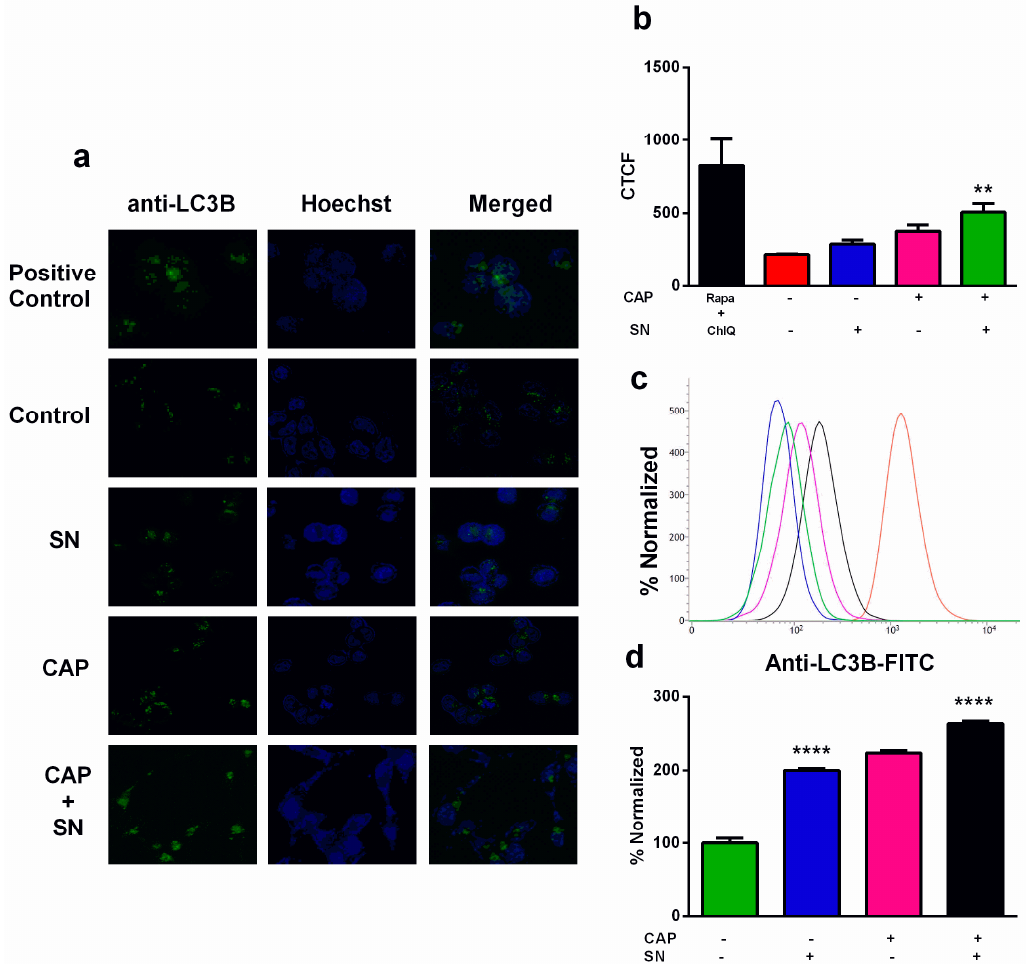
Figure 6 . Interpretation of autophagic flux using a kit (Cyto ID® autophagy detection kit) ( a ) by confocal microscopy (green dots represent autophagic sites within G-361 cells and blue stains signify nuclei); ( b ) autophagy image intensities were expressed in terms of CTCF values using bar graphs; ( c ) flow cytometry evaluation of autophagy determination using anti-LC3B FITC-labeled dye; ( d ) FITC expression for autophagy was expressed in terms of a bar graph. Data are the mean ± SE of three experiments. Statistical analysis was performed using a one-way ANOVA test followed by Dunnett’s test for comparisons. Each asterisk represents statistical differences between the treatment and control (** p < 0.01 and **** p < 0.0001).